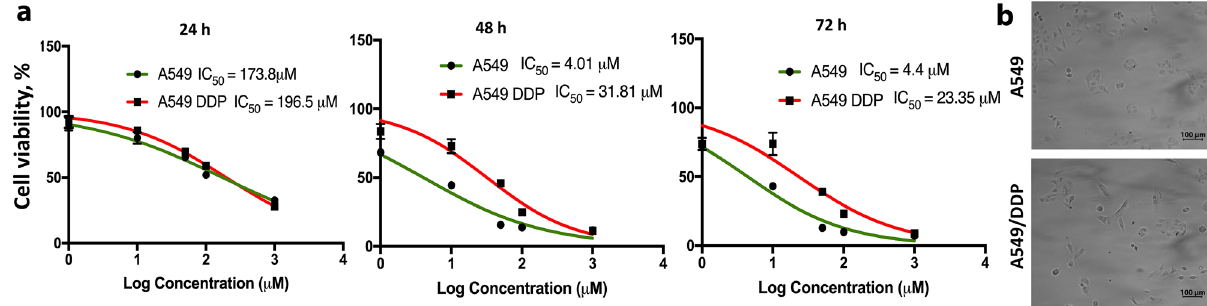
Figure 1. Cytotoxicity analysis of CDDP in A549 and A549/DDP cells. ( a ) We determined the IC50 values of CDDP in the resistant and parent A549 cells following 24, 48, and 72 h of incubation. ( b ) Representative pictures of A549 and A549/DDP cell cultures (Scale bar: 100